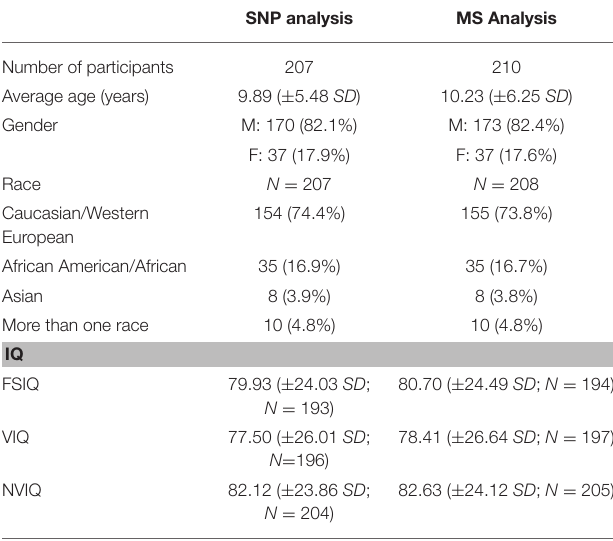
TABLE 1 | Demographic description of the probands